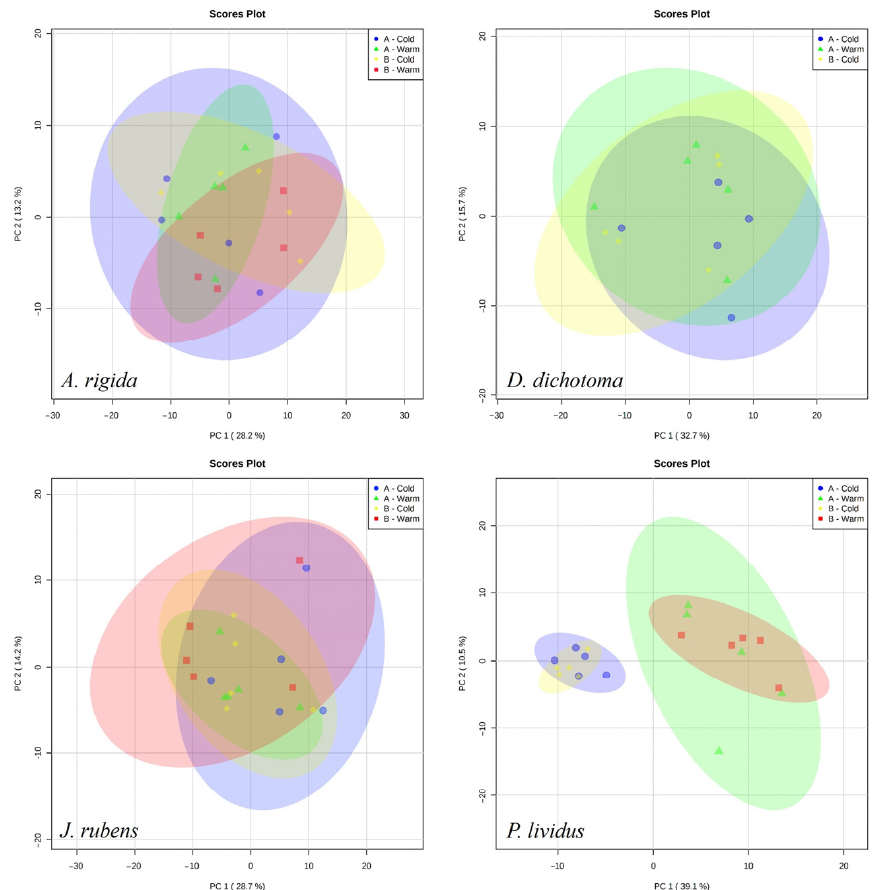
Figure 4. PCA scores plot for the metabolite fingerprint in the three main species of macroalgae and P. lividus at the different stations and seasons of the study.